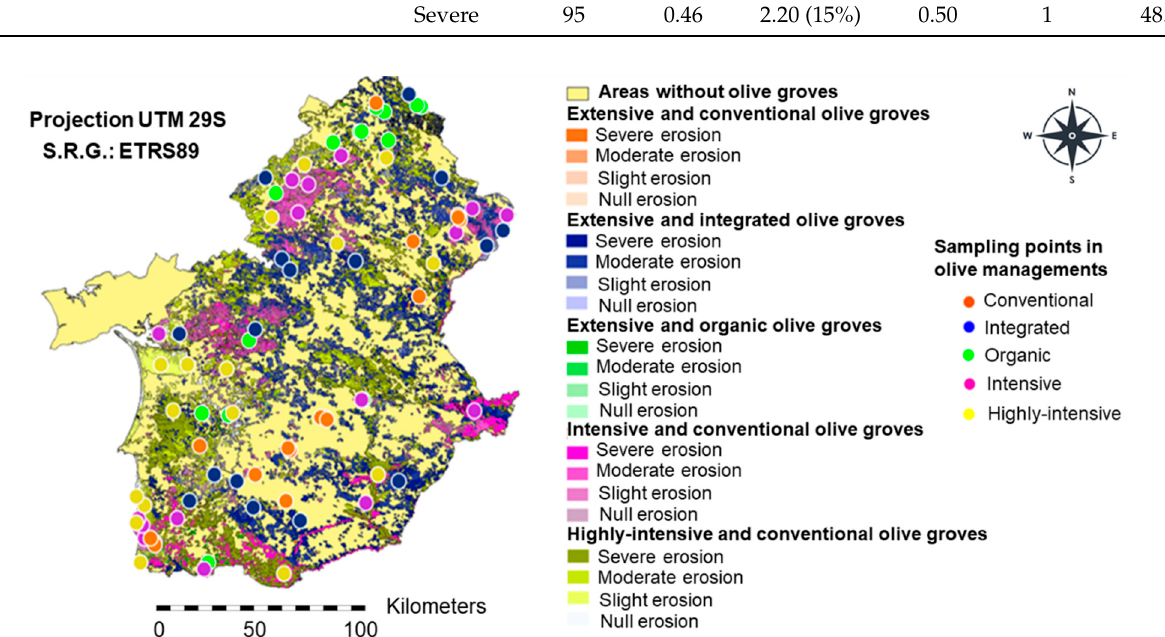
Figure 2. Sampling design (sampling points) carried out in the study area according to the existing types of olive groves (plant densities and management systems) and erosive states calibrated through the USLE equation.